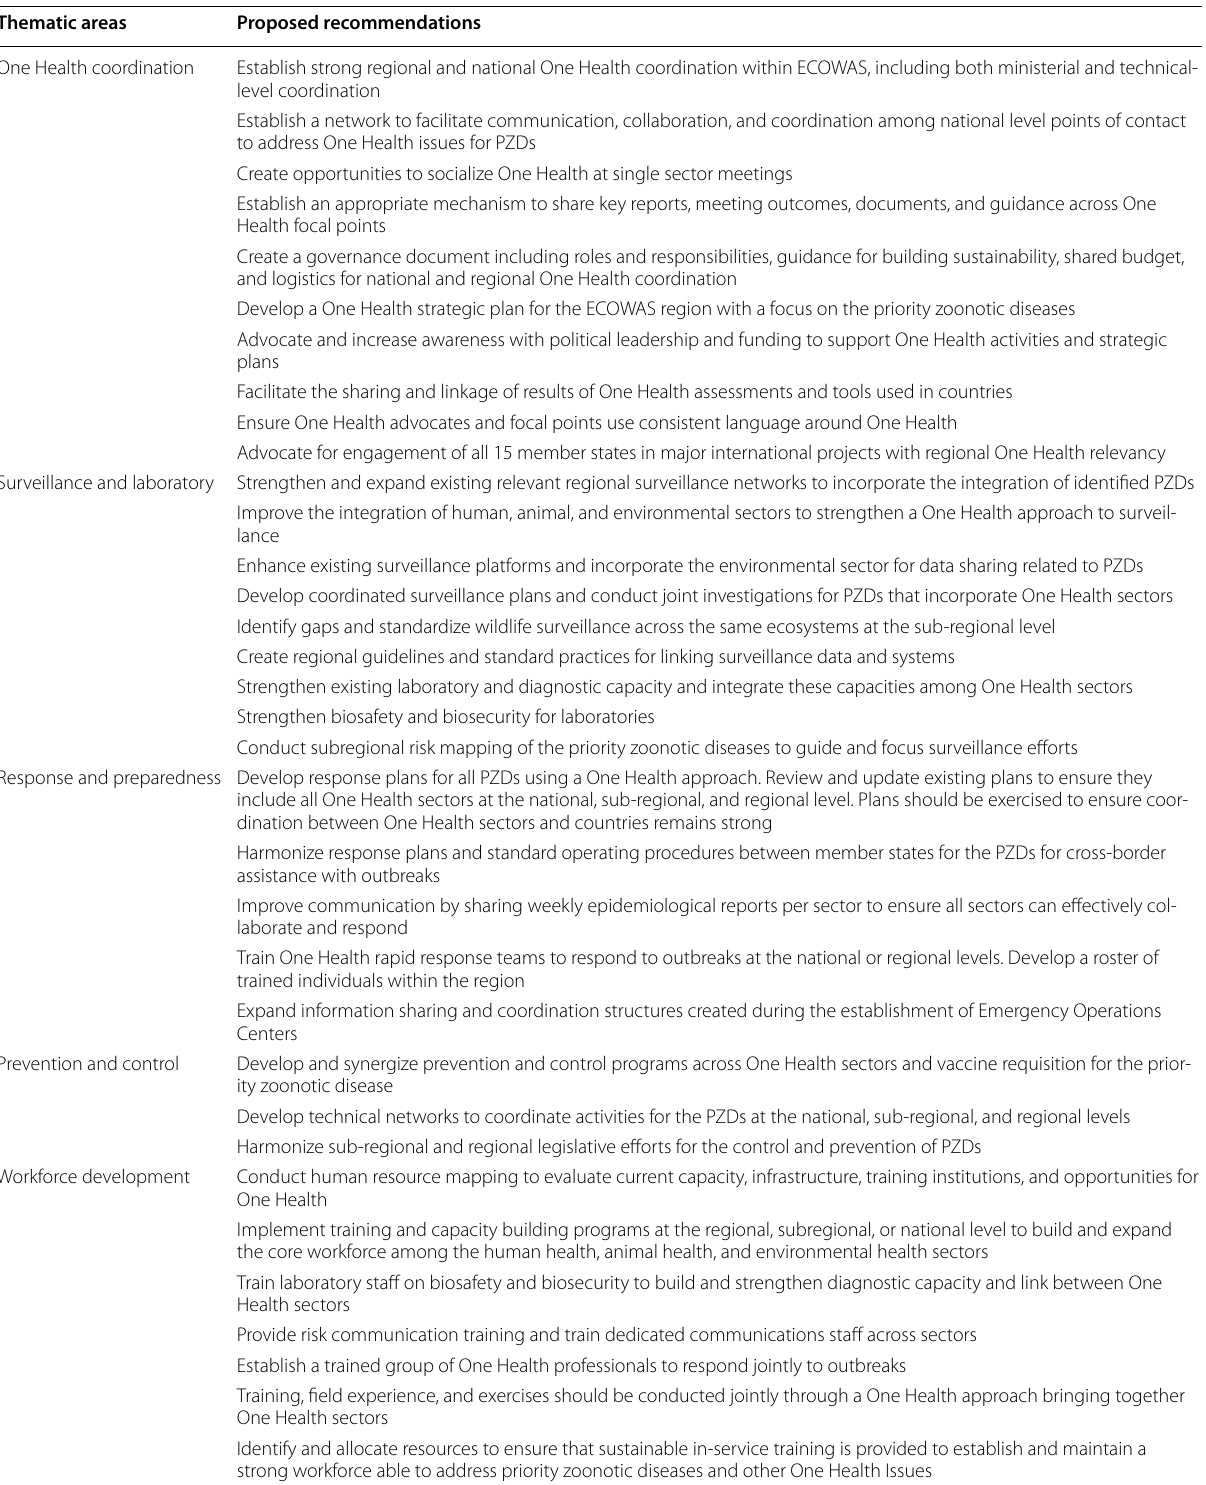
Table 4 Recommendations agreed upon by ECOWAS for the priority zoonotic diseases (PZDs) and One Health collaboration Thematic